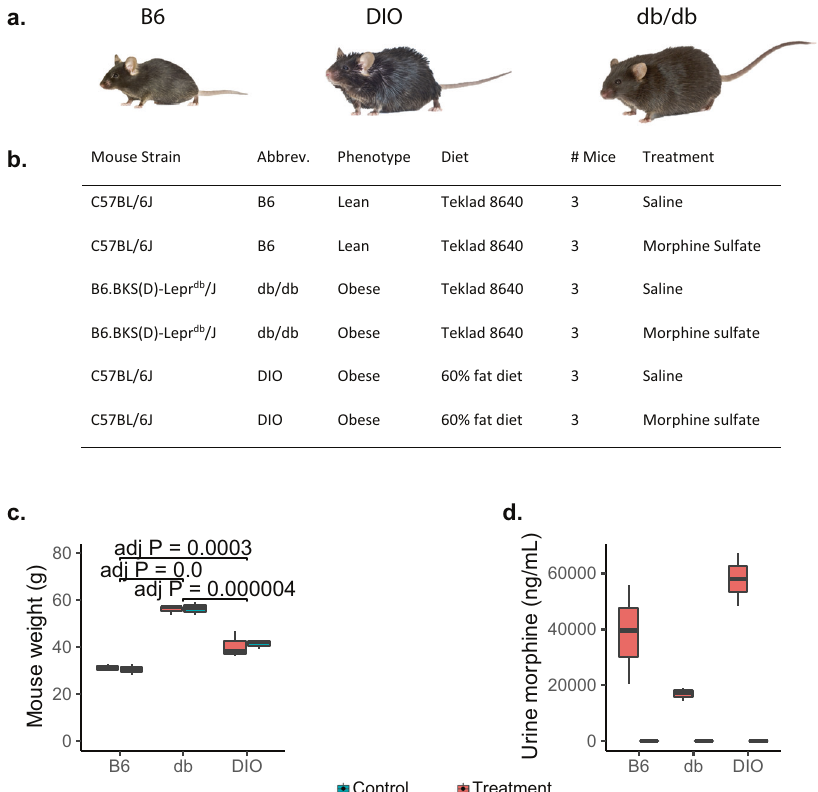
Fig. 1 Experimental design. a Images depicting the phenotypic differences between the mice, printed with permission from © The Jackson Laboratory. b Table describing the different experimental groups. All measurements were conducted on all mice. c Boxplot depicting weight of mice at time of sample collection. P values calculated by TukeyHSD, only a single signi fi cant digit reported. d Boxplot depicting morphine quantities in mouse urine analyzed by triple quadrupole mass control) ( n = 9), or morphine administered continuously for two weeks via implanted ALZET pumps ( n = 9). The three mouse groups had different weights, with db/db mice heavier than DIO, and DIO heavier than B6 mice, as has been previously noted (Fig. 1c, Supplementary Table S1) [18]. Morphine-derived meta- bolites were detected only in mice treated with morphine, with the db/db mice having signi fi cantly lower levels of such metabolites (Fig. 1d, Supplementary Table S1). Microbiome samples were collected by extracting intact feces directly from the colon via surgery.